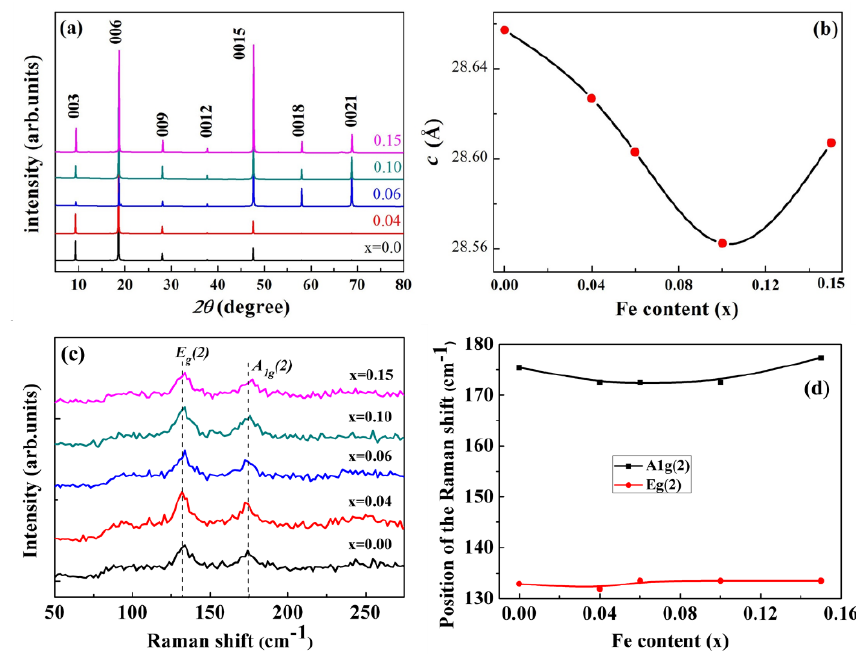
Figure 4. With different Fe concentrations: ( a ) the XRD patterns of Fe x Bi 2- x Se 3 ; ( b ) the lattice constant c decreasing (the red points represent the lattice parameters of c in the (006) direction with the different Fe doping concentrations); ( c ) the Raman spectra of the Fe x Bi 2- x Se 3 single crystals; and ( d ) the position of the Raman peaks.